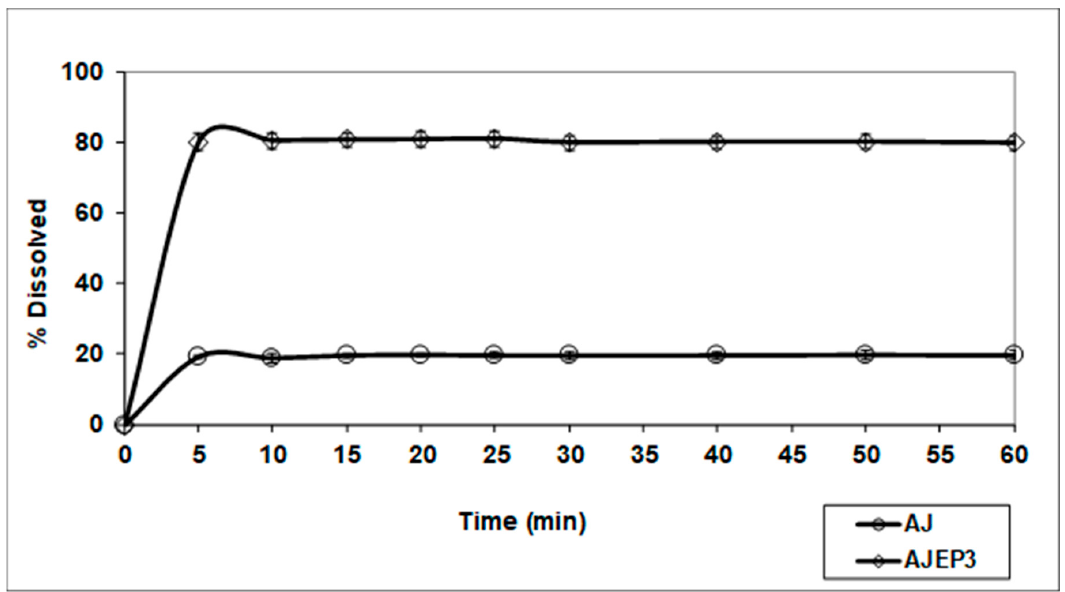
Figure 11. Dissolution/release profile of AJEP 3 microparticles compared with AJ (unprocessed extract). The amount of the extract dissolved was measured calculating the content of teupolioside ( 4 ) by UV-method.